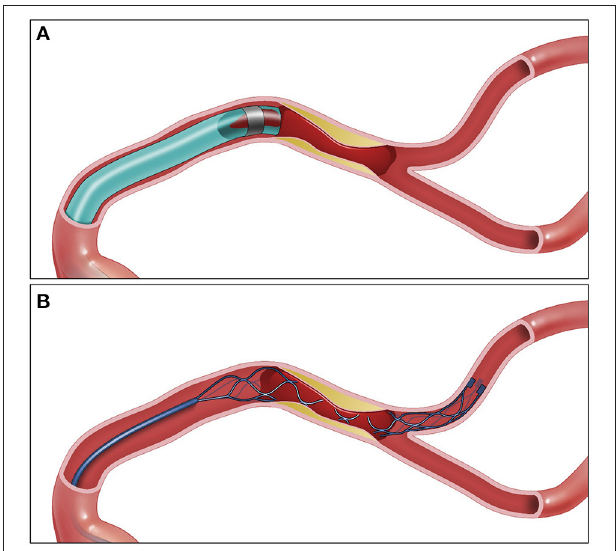
FIGURE 1 | ADAPT vs. SR for EVT in ICAS ELVO. (A) Aspiration catheter engulfing the proximal end of the thrombus. (B) Stent retriever engulfing the thrombus—the stent retriever shape is changed at the location of the plaque. SR, stent retriever; ADAPT, a direct aspiration first pass technique; MT, mechanical thrombectomy; ICAS, intracranial atherosclerosis; ELVO, emergent large vessel occlusion.